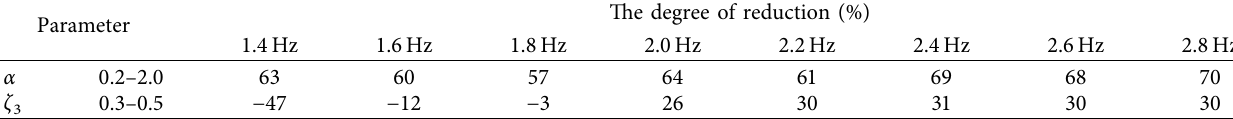
Table 7: The max VDV corresponding to variate parameters of passive crowd.